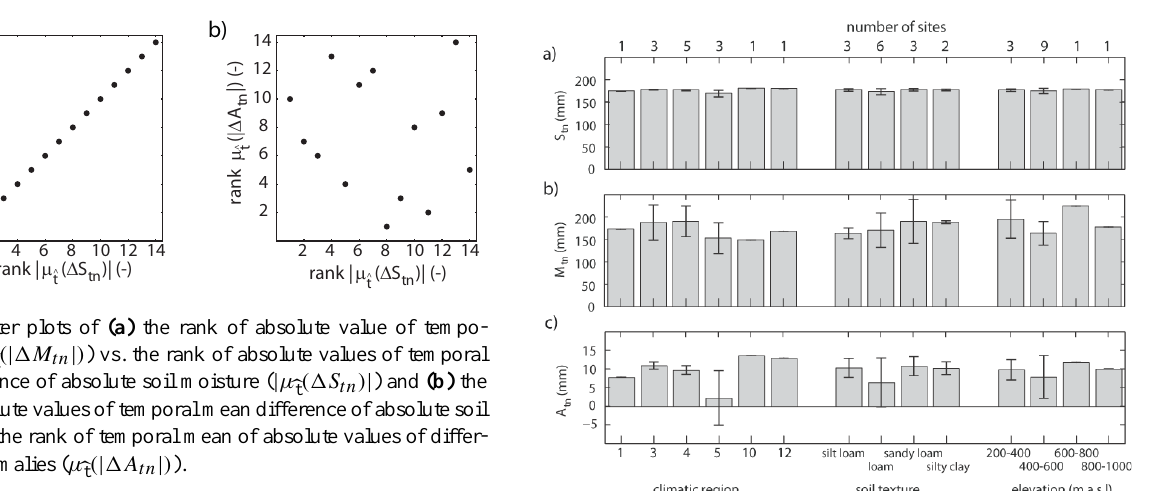
Fig. 8. Rank stability plots of (a) the absolute value of temporal mean ( µ ( | 1A tn | ) ). The vertical lines represent ± one standard deviation. The sites have been ranked according to their differences of anomalies ( µ b t mean differences.